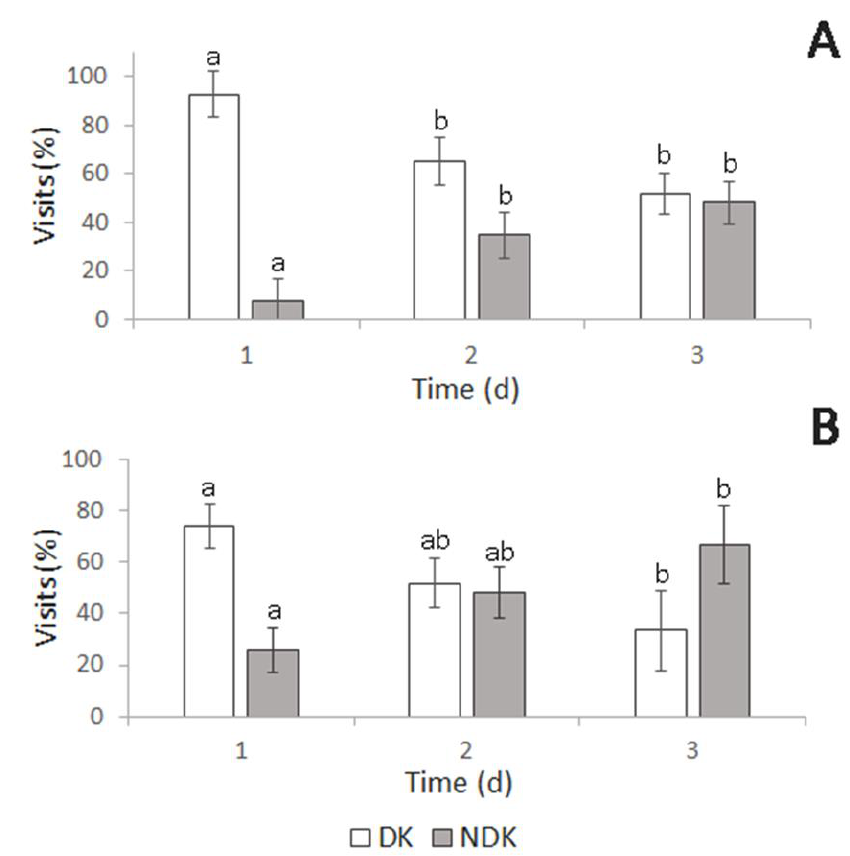
Figure 4. Percentage of the behaviour by Apis mellifera (A) and Bombus terrestris (B) to down completely (DK) and not to down completely the keel (NDK) of V. faba flowers along three days of its life. When the insect lowers the keel, he collects pollen. For A. mellifera and B. terrestris day was a significant factor using logistic regression ( P = 0.0008 and P = 0.02, respectively). The first day was different for A. mellifera (Wilcoxon, P = 0.03 compared to day 2 and P = 0.003 compared to day 3), day 2 and 3 were similar ( P = 0.3) and for B. terrestris , only day 3 is marginally different from day 1 ( P = 0.09). The standard error is